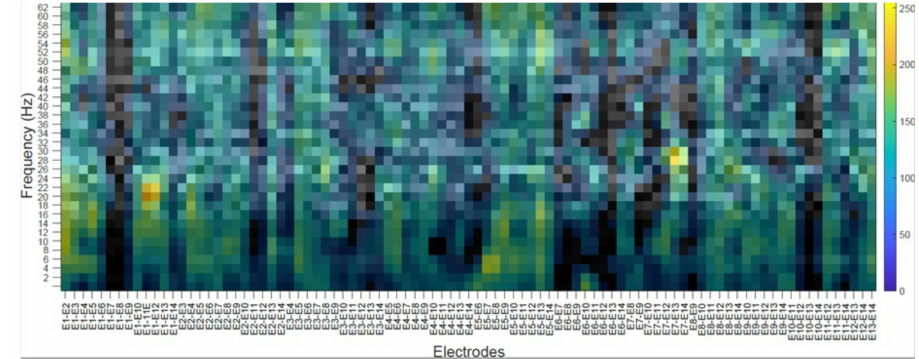
Figure 10. Subject’s internal representation (CAM) in imagined tasks of the vowel /i/. The horizontal axis represents the difference between electrodes and the vertical axis, the corresponding